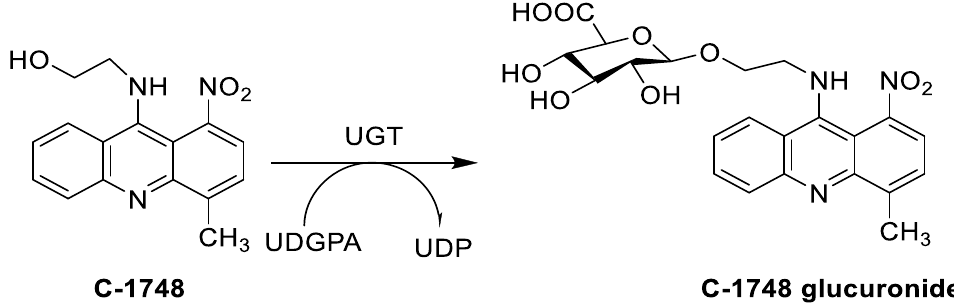
Figure 2. C-1748 phase I metabolic pathway.